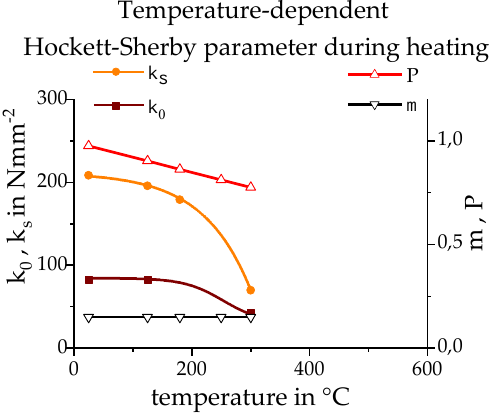
for alloy EN AW-6060 T4 at different temperatures during heating at 100 Ks −1 .